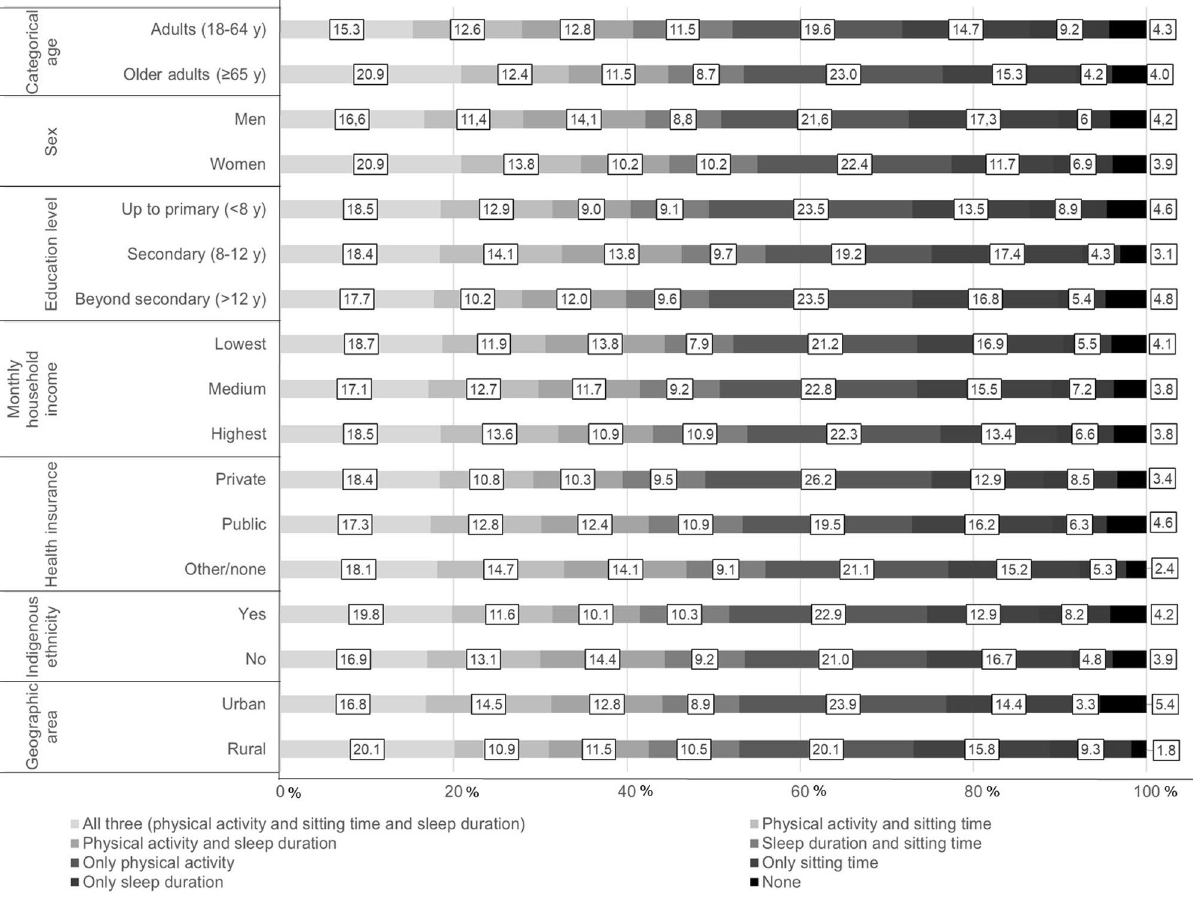
Figure 3. Proportion (%) of participants meeting the specific combinations according sociodemographic